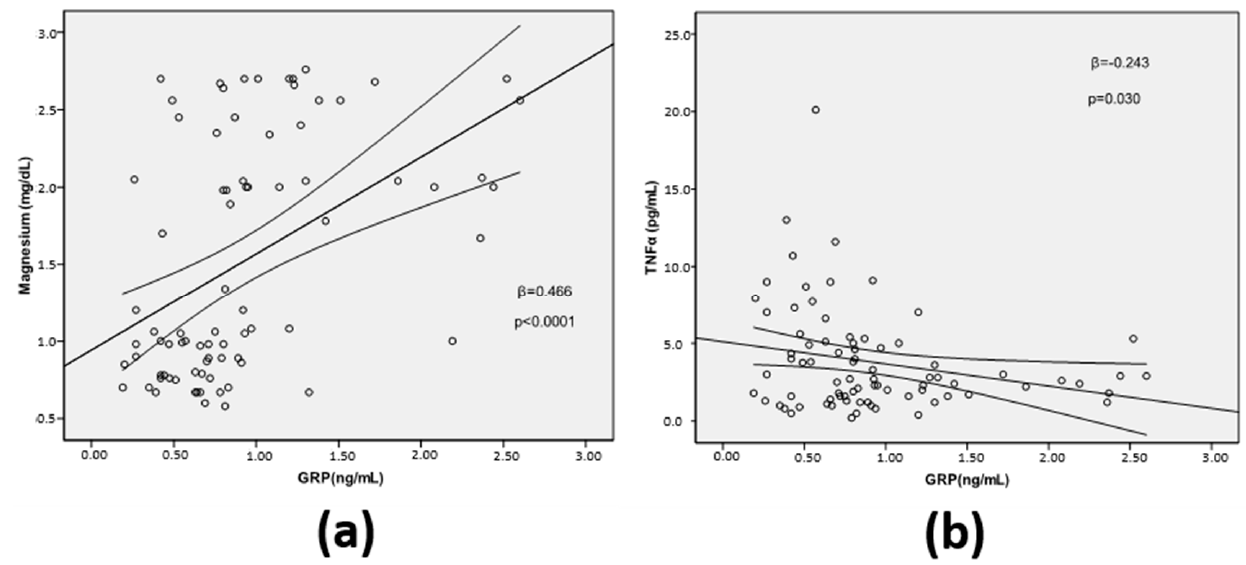
Figure 2. Association between Gla-rich protein (GRP) serum levels and magnesium (Mg) ( a ), and tumor necrosis factor alpha (TNF α ) ( b ), using the simple linear regression analysis. Partial correlations between GRP levels, mitral valves calcification and eGFR were analysed after adjustments for age and gender. A strong negative correlation was found between GRP and mitral valves calcification (r = − 0.754, p < 0.0001), and a strong positive correlation with eGFR (r = 0.823, p < 0.0001), while a weak negative correlation was found between mitral valves calcification and eGFR (r = − 0.421, p < 0.0001) (Table 2). Highly similar results were obtained for partial correlation analysis between GRP levels, aortic valves calcification and eGFR after adjustments for age and gender (Table 3). Table 2. Partial correlation analysis between GRP, calcified mitral valve and estimated glomerular filtration rate (eGFR) after adjustments for age and gender. Calcified Mitral GRP Variables − 0.754 <0.0001 1.00 − 0.421 <0.0001